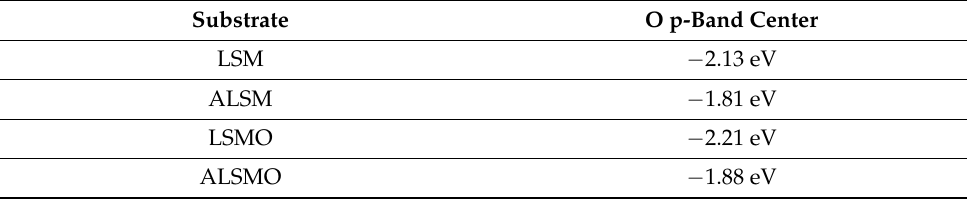
Table 2. Oxygen p-band centers of LSM, ALSM, LSMO, and ALSMO